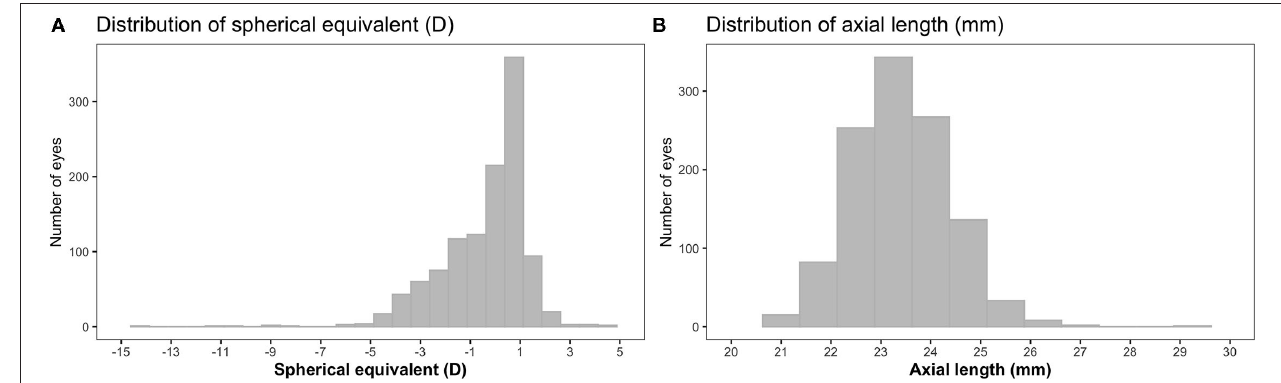
FIGURE 1 | Distributions of spherical equivalent (SE) (A) and axial length (AL) (B) in children from the Growing Up in Singapore Towards healthy Outcomes (GUSTO) cohort ( n = 572). D, diopters.